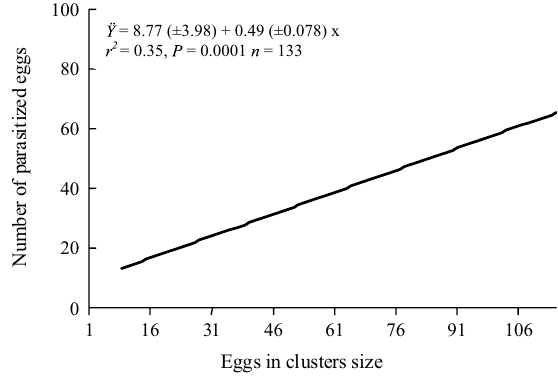
Fig. 1 – Effect of egg cluster size of Euselasia eucerus (Lepidoptera: Riodinidae) on natural parasitism by Trichogramma maxacalii col- lected in the Municipality of Caeté, Minas Gerais State, Brazil.